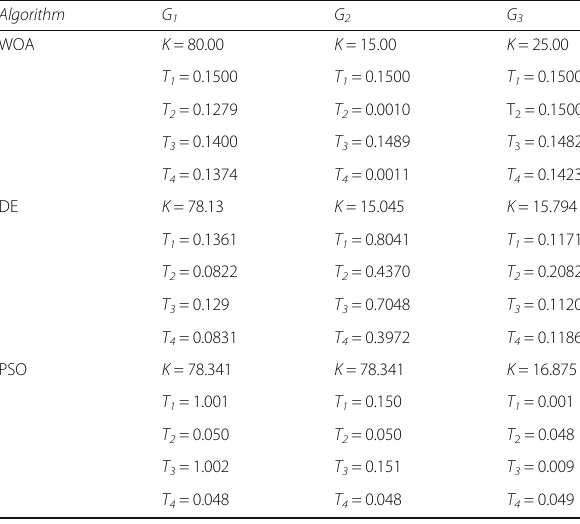
Table 3 Optimized Parameters using PSO,DE and WOA for case